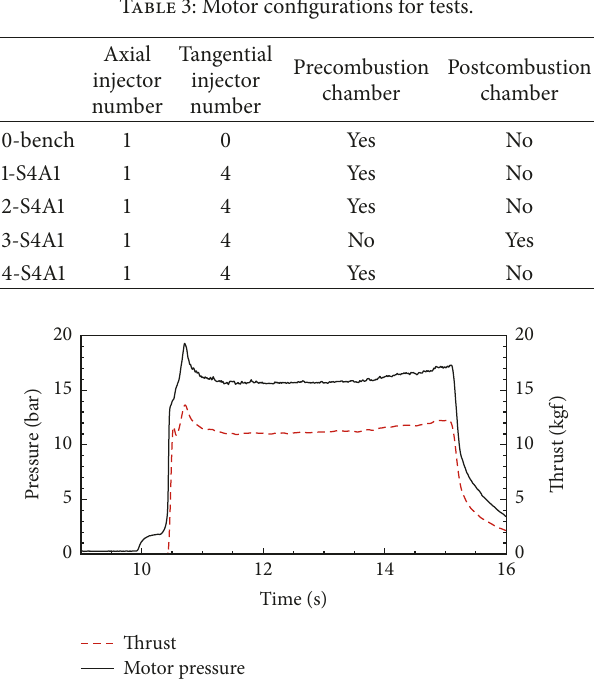
Table 3: Motor configurations for tests.